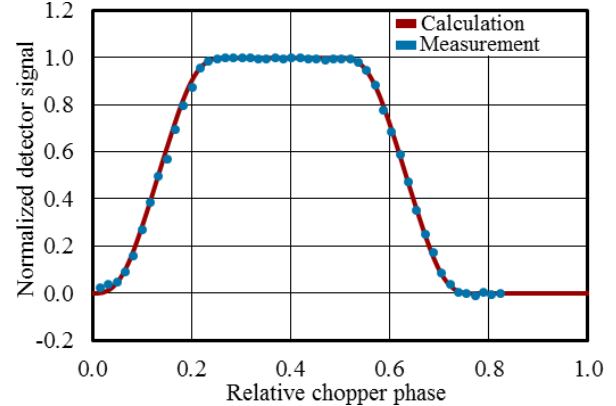
Figure 6. Normalized detector signal of the thermopile detector measured when rotating the chopper wheel in front of the blackbody step by step (blue) and the result of the model function according to Eq. (25)